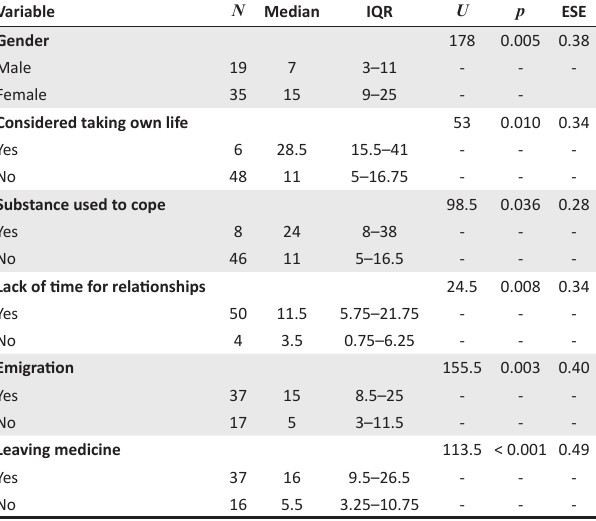
TABLE 2: Features associated with depressive symptomatology.